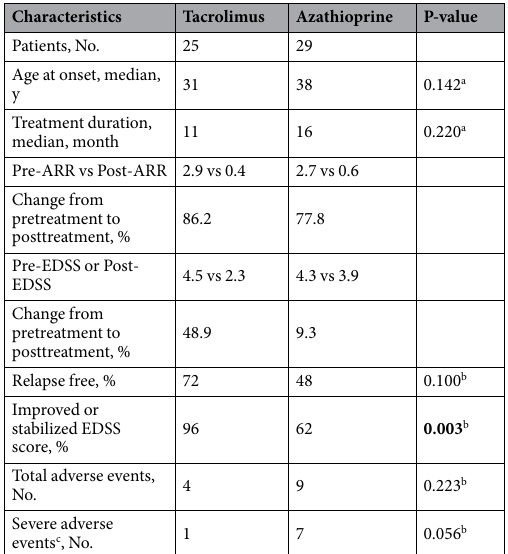
Table 5. Comparison between patients who received tacrolimus and those who received azathioprine. ARR: annualized relapse rate; EDSS: Expanded Disability Severity Scale. a Mann-Whitney U test. b Fisher’s exact test. c severe adverse events included agranulocytosis, liver damage, and death etc. Azathioprine could reduce the ARR and EDSS score by 77.8% and 9.3%, respectively. However, in comparison with tacrolimus treatment, azathioprine therapy provided a relatively lower relapse-free rate and a significantly lower rate of improved or stabilized EDSS score (relapse-free rate, 48% vs 72%, P = 0.1; rate of improved or stabilized EDSS score, 62% vs 96%, P = 0.003). Azathioprine group exhibited considerably higher adverse events occurrence of total adverse events (31%) and severe adverse events (24%) than observed in tacrolimus group (16% and 4%,